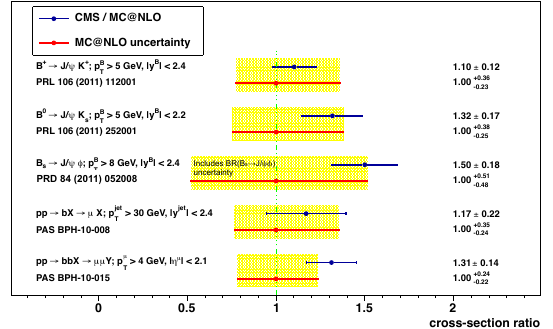
   y B  < 2.2. The > 5GeV and Figure 1: Projections of the fit results in (a) m B and (b) ct for p B T (center) and B s → J /ψφ (right). The CMS data points curves in each plot are as follows: the sum of all contributions (blue solid line); the prompt J/ y s (green dotted); the sum of the prompt J/ y and peaking background (red dashed), and the sum of all backgrounds (purple dot-dashed).